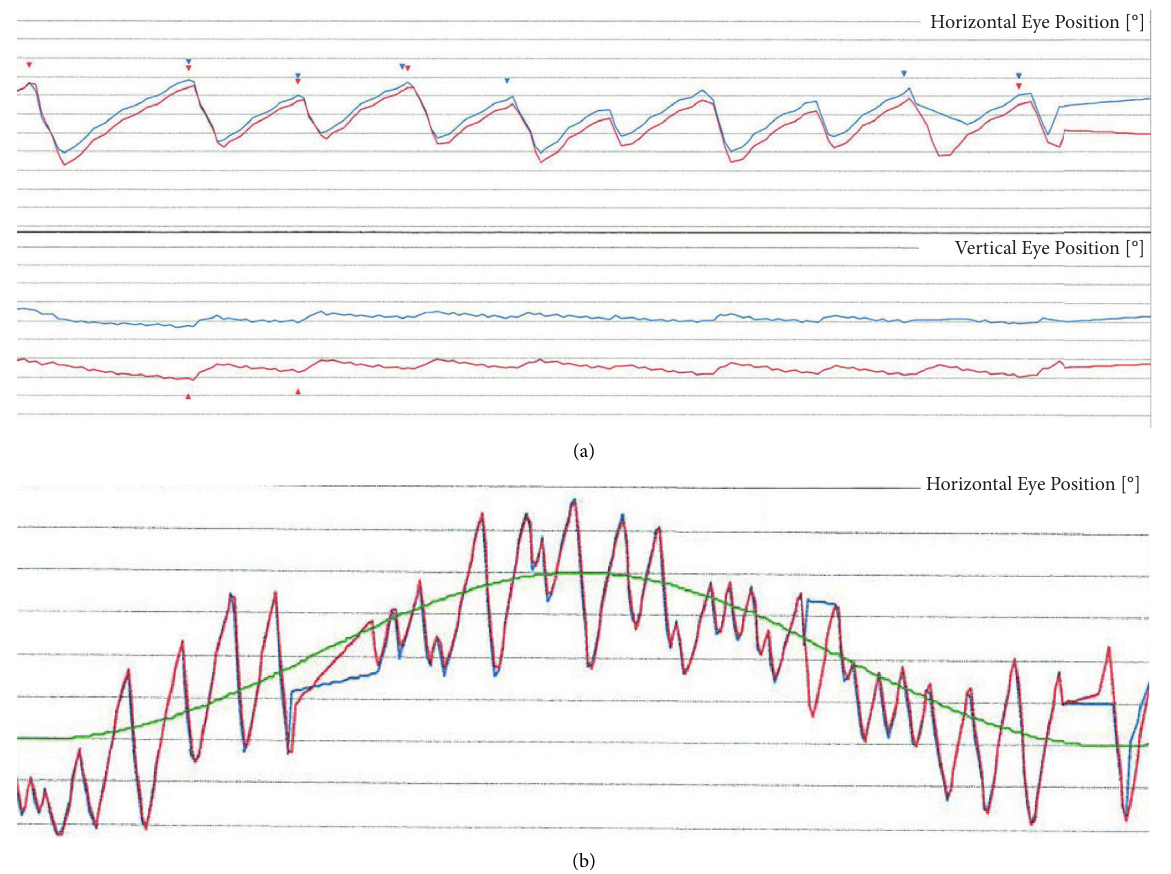
Figure 1: The records of spontaneous nystagmus of the first sister in the primary position (a) and during execution of pursuits (b).